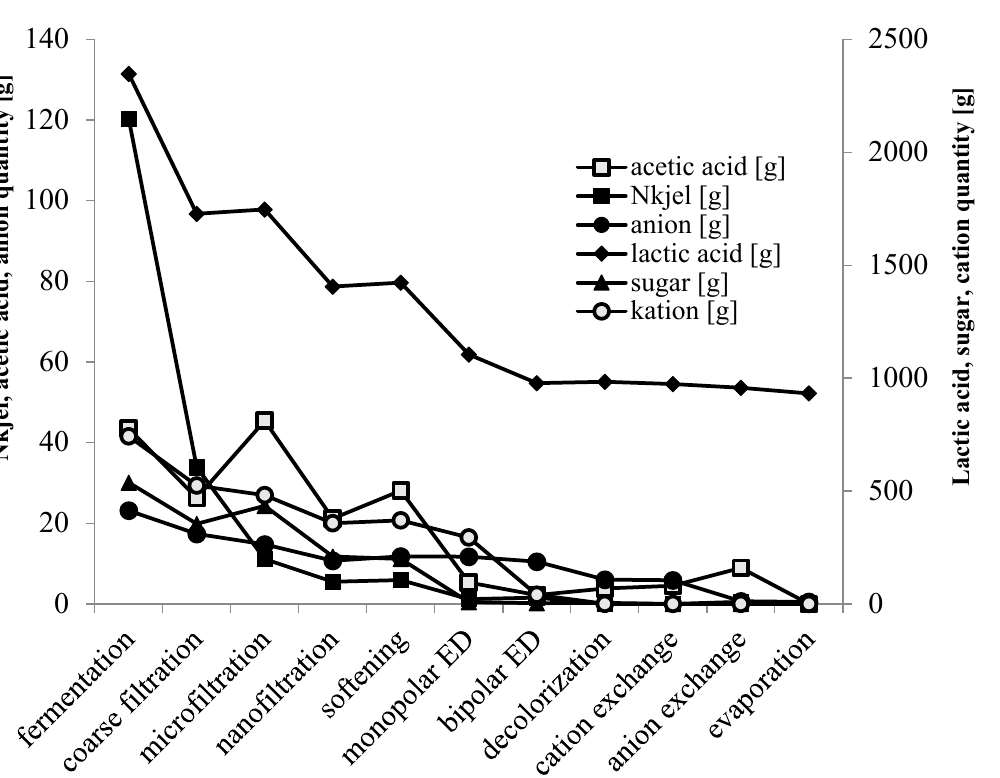
Figure 4. The average compositional analysis of lactic acid, acetic acid, and sugar content following every step of the downstream process in the two pilot scales of the carob bagasse fermentation with 30% solids.